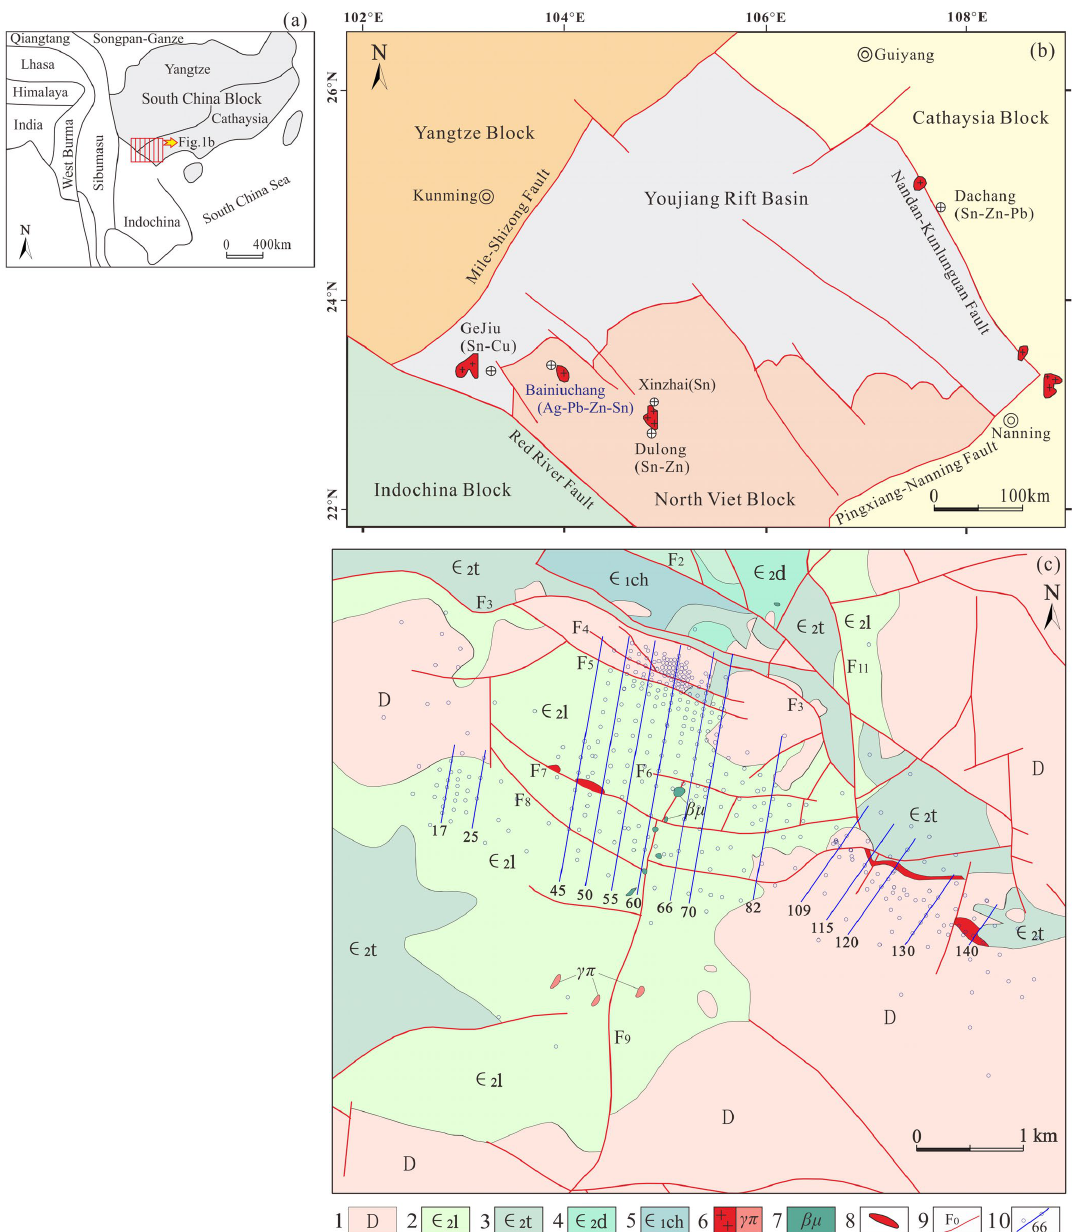
Figure 1. Geological maps of the Bainiuchang deposit. ( a ) Simplified map of Eastern Asia showing major tectonic units (modified using Ref. [21]). ( b ) Regional geological map (modified using Ref. [22]). ( c ) Geological map of the Bainiuchang mine area: 1. Devonian strata; 2. middle Cambrian Longha Formation; 3. middle Cambrian Tianpeng Formation; 4. middle Cambrian Dayakou Formation; 5. lower Cambrian Chongzhuang Formation; 6. Yanshanian granite and granitic porphyry ( γπ ); 7. diabase; 8. ore body; 9. fault; and 10. exploration line and drill hole.